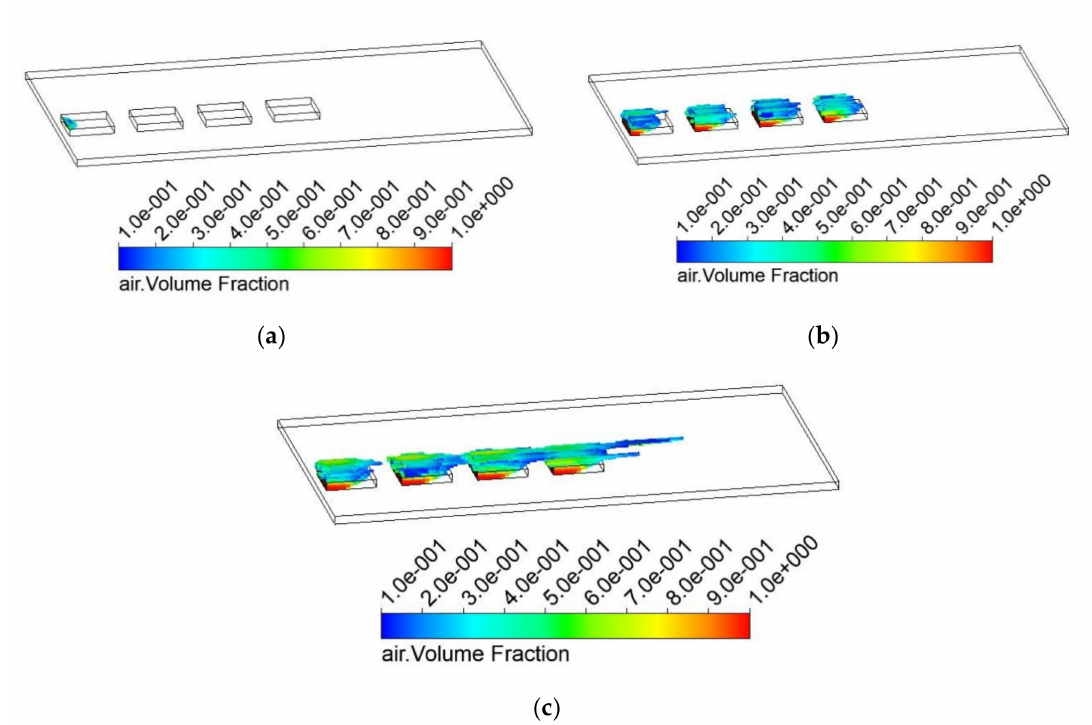
Figure 26. The air volume fraction is generated by a partial texturing configuration with dimples side 50 µ m and gap 8 µ m, sliding velocity 10 m / s. Set B of the cavitation coe ffi cients. Only the portions of the mesh where the volume fraction of air is greater than 10% are highlighted. ( a ) Saturation pressure − 0.7 bar; ( b ) Saturation pressure − 0.5 bar; ( c ) Saturation pressure − 0.3